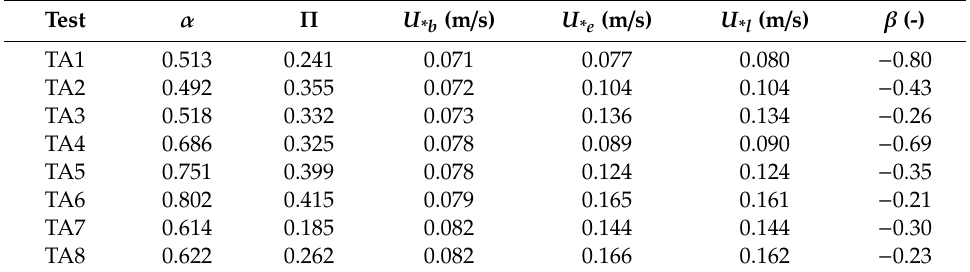
Table 2. Ratios of apparent shear stresses at the water surface to bed shear stresses ( α ), wake parameters ( Π ), and mean friction velocities calculated using bed slope, energy line slope, and logarithmic